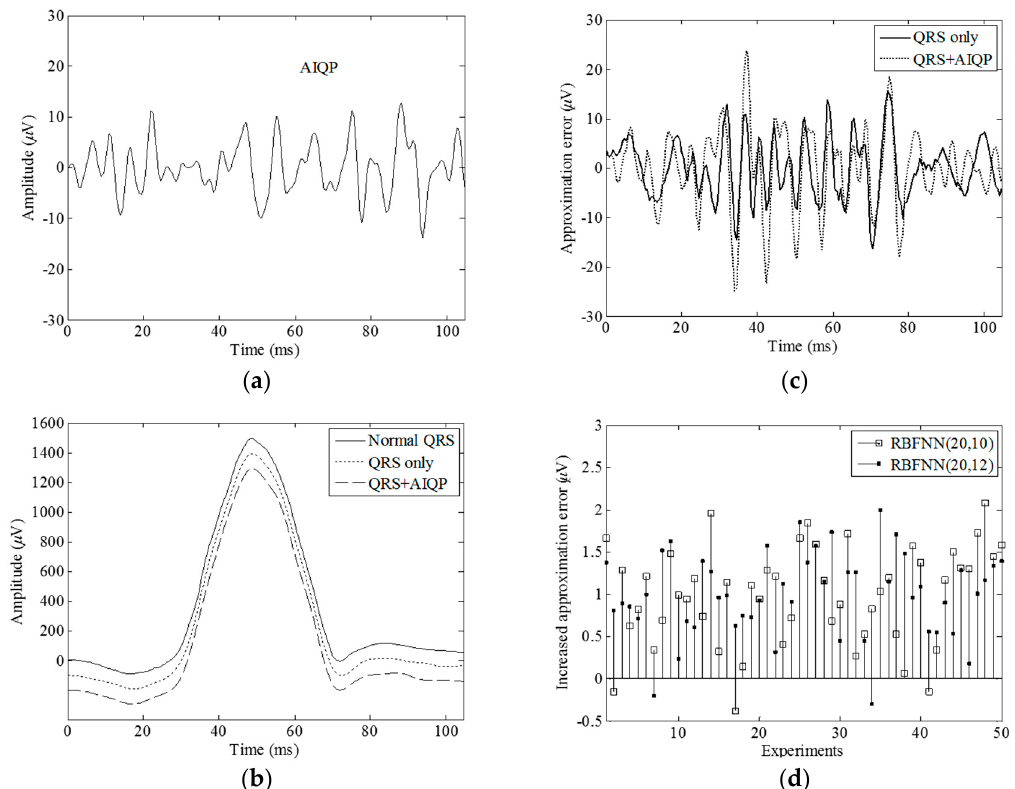
Figure 2. Simulation results for a normal QRS complex in the presence and absence of a simulated AIQP: ( a ) an AIQP simulated as 40–250 Hz colored noise; ( b ) a normal QRS complex (solid line) simulated as an X-lead QRS complex of a normal subject, the approximation outputs in the absence (dotted line) and the presence (dashed line) of AIQP using an RBFNN (20, 10); ( c ) the approximation errors in the presence (dotted line) and the absence of (solid line) AIQP using the RBFNN(20, 10); and ( d ) the increase in the approximation errors using the RBFNN(20, 10) and an RBFNN(20, 12). RBFNN ( M , σ ) denotes a radial basis function neural network with M neurons and a spread parameter of σ .